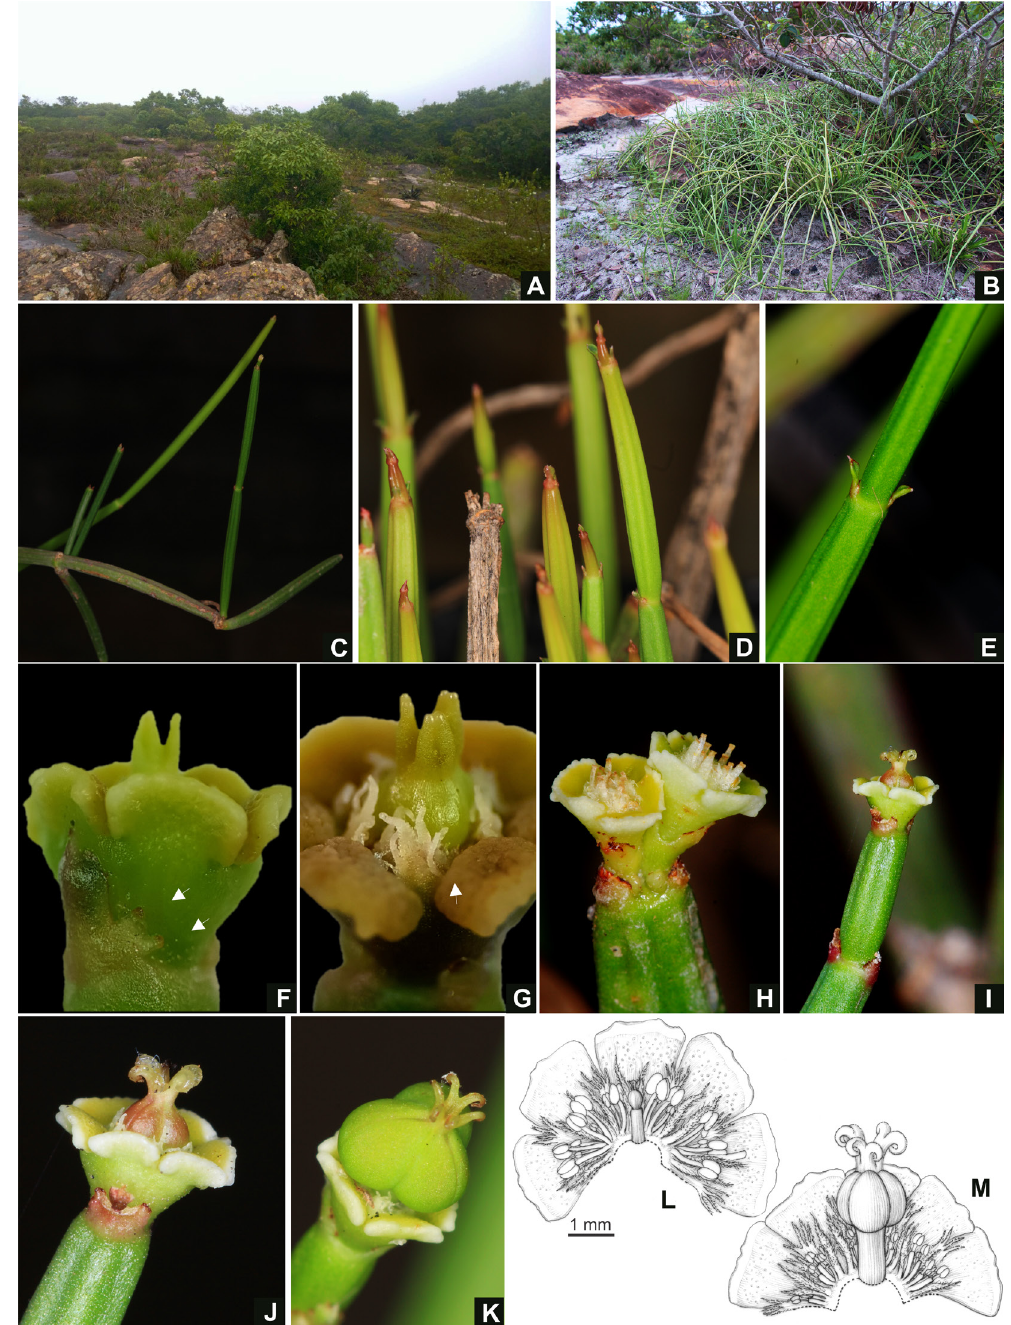
Fig. 4. Euphorbia sobolifera O.L.M.Silva & P.J.Braun sp. nov. A . Habitat. B . Habit. C . Portion of a branch producing soboles. D . Apical portion of branches with reduced opposite leaves. E . Detail of a node with opposite leaves. F . Cyathium showing one of the cyathophylls bearing colleters on its margin (arrows). G . Detail of a cyathium showing an involucre lobe (arrow). H . Grouped staminate cyathia. I . Solitary pistillate cyathium. J . Detail of a pistillate cyathium showing the pistillate flower. K . Immature fruit. L . Staminate cyathium opened, showing staminate cymules, bracteoles and a central pistillode. M . Pistillate cyathium opened, showing poorly developed staminate flowers and bracteoles. Photos: A–B: P.J. Braun in the field; C–K: O.L.M. Silva; L–M: Illustrations of plants cultivated at